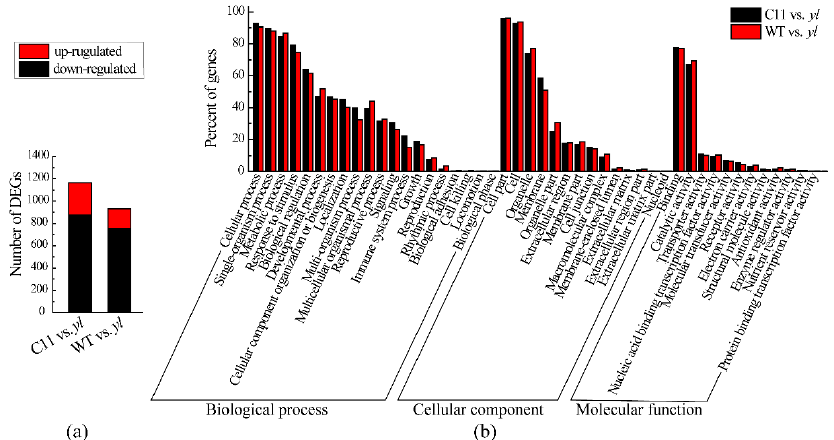
Figure 5. Differentially expressed genes (DEGs) analysis based on Gene ontology. ( a ) Number of DEGs in C11 vs. yl and WT vs. yl . ( b ) Gene ontology classification of DEGs in C11 vs. yl and WT vs. yl